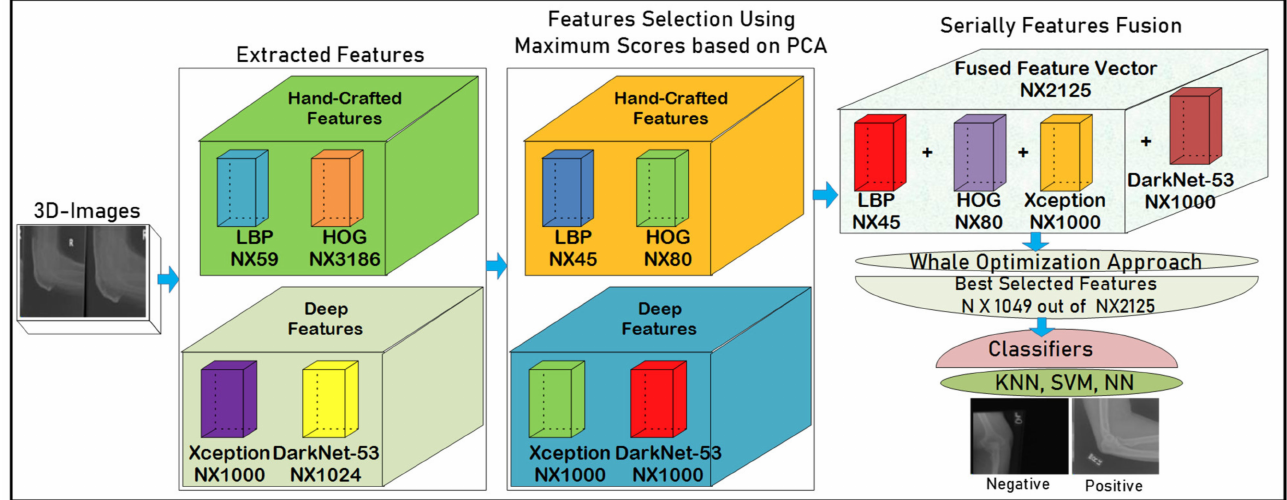
Figure 2. Proposed feature extraction, score-based feature selection, fusion, and best feature selection using WOA and classification.